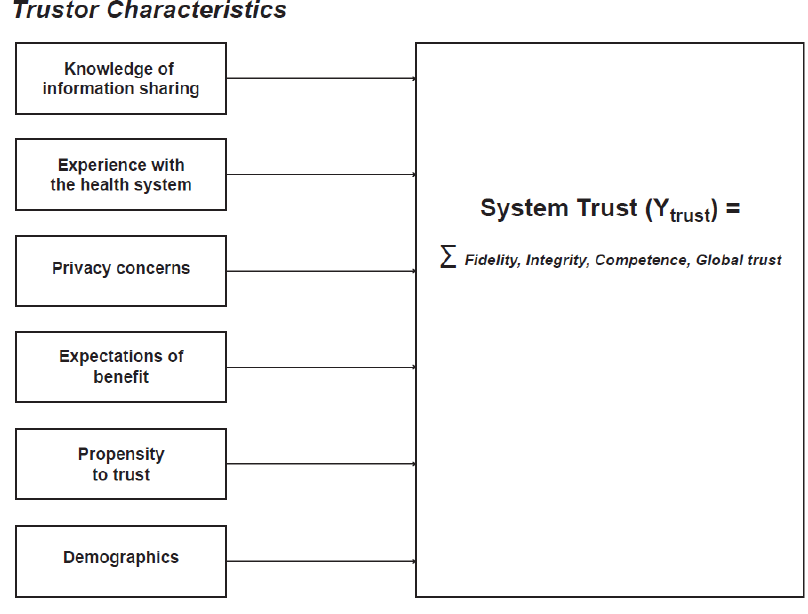
Figure 1. Conceptual